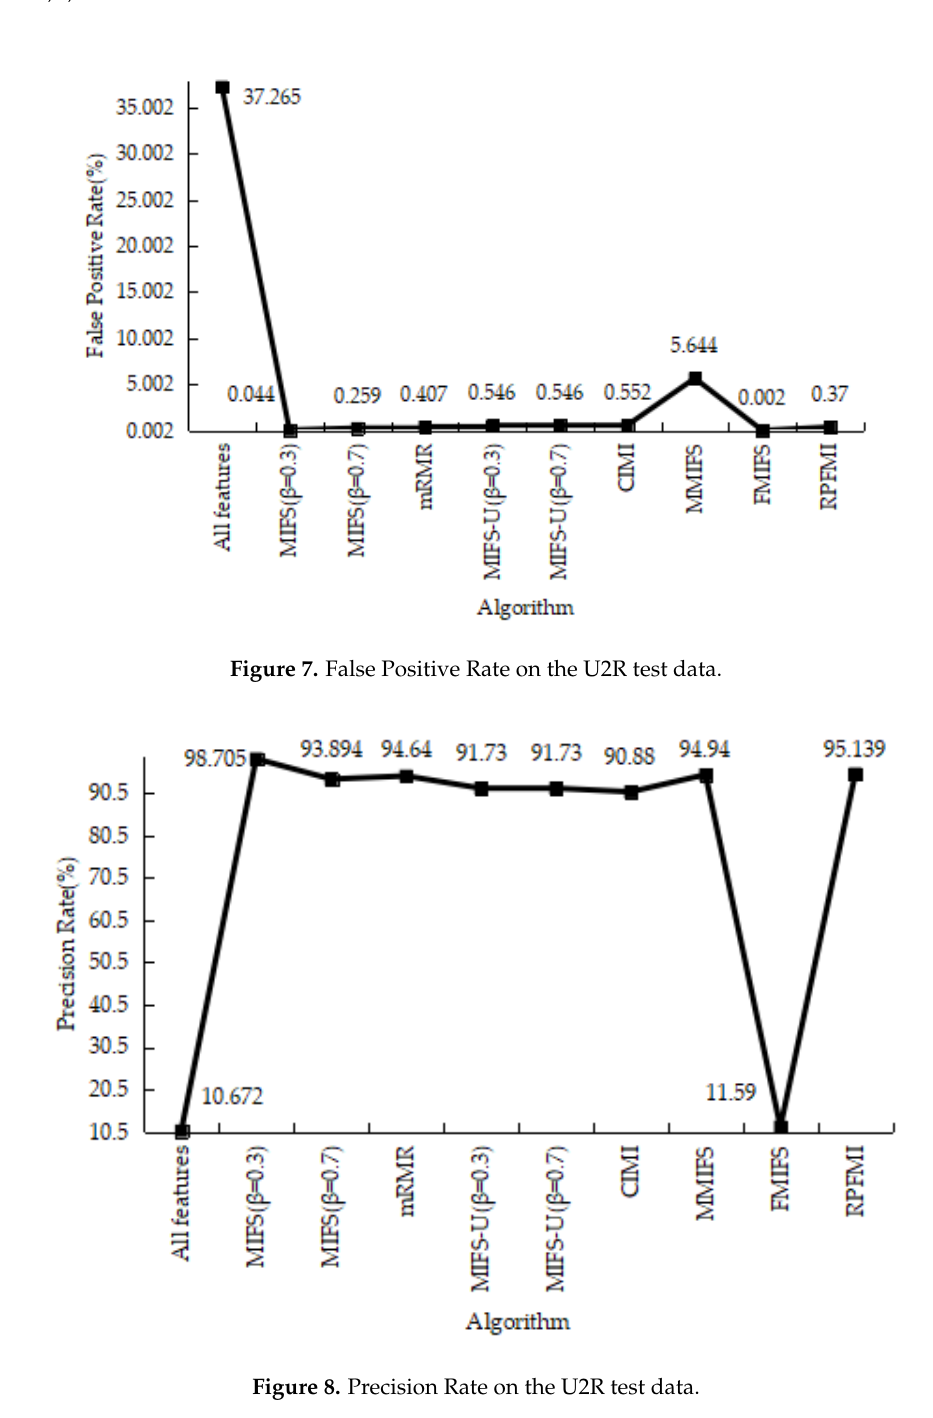
Figure 6. Detection Rate on the U2R test data.